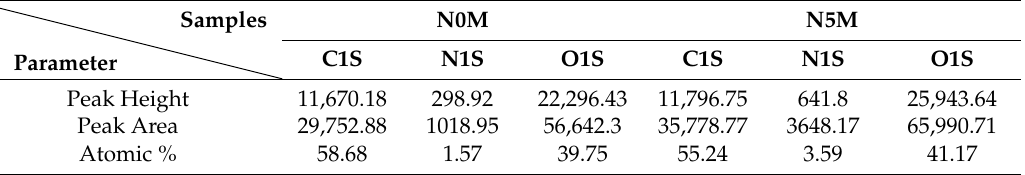
Table 3. The parameters of the C, N, and O XPS peaks for the raw lignite and modified lignite samples.